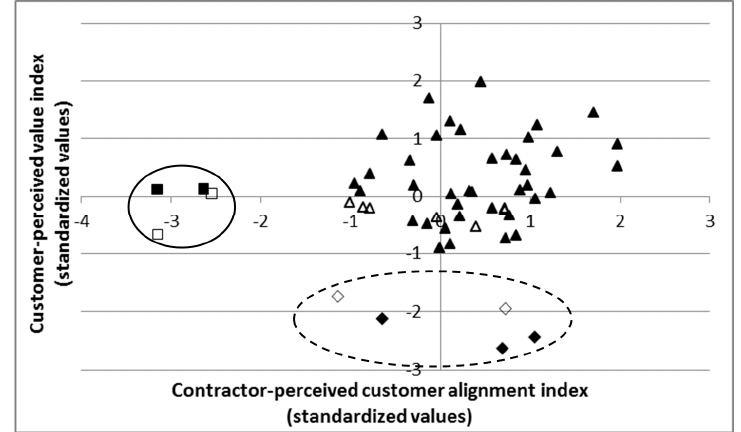
Figure 1. Customer–contractor alignment from two different perspectives for 55 responding contractors. Filled (black) symbols represent contractors that still worked for the customer, whereas unfilled symbols represent contractors that ceased to work for the customer. Group A (squares, and circled by solid line) include low perceived alignment by contractor, and Group B (diamonds, and circled by a dotted line) include low performing contractors from the client’s perspective.